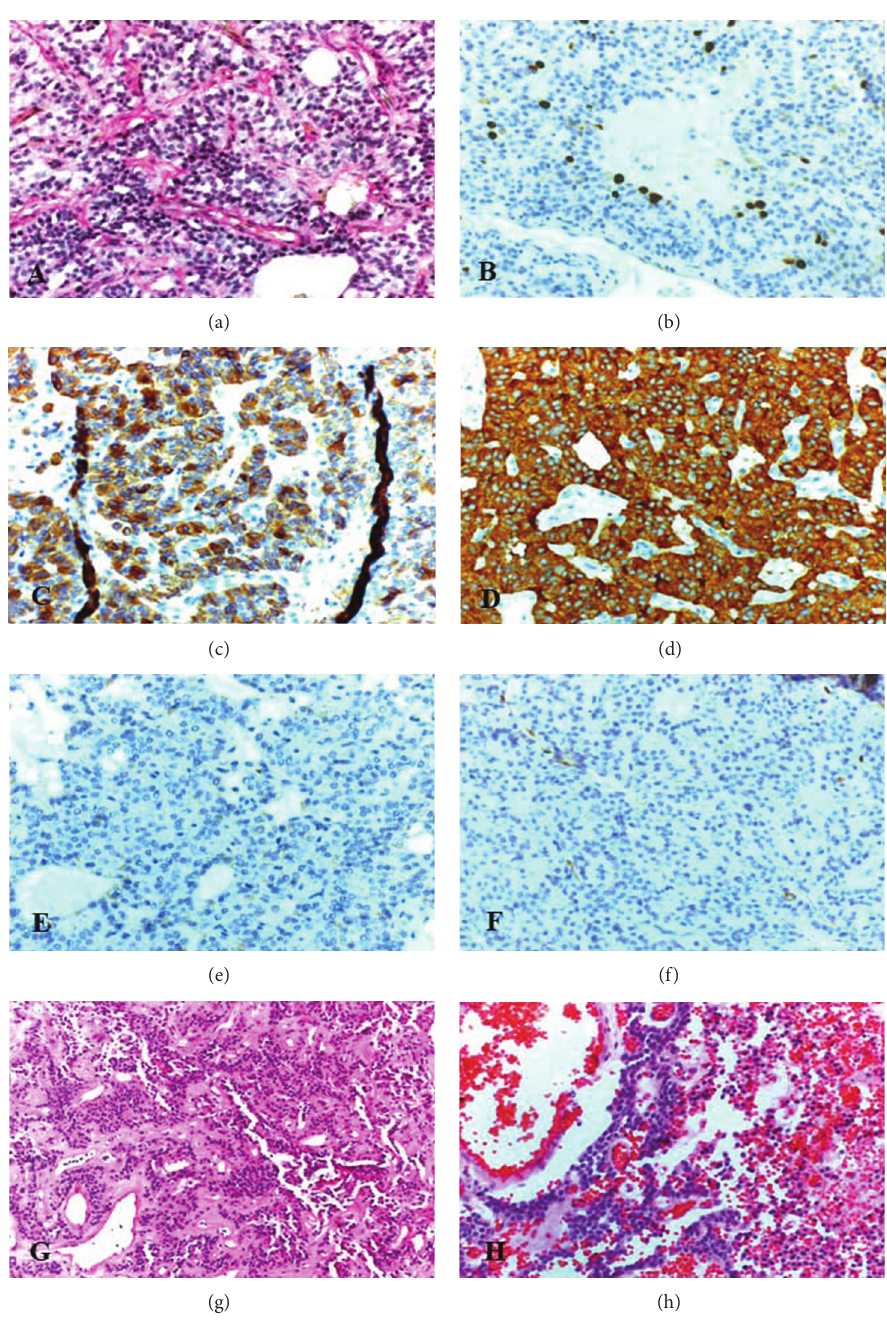
Figure 2: Tumor histomorphology at different time points. (a) In 2007, excised mostly monomorphic highly cellular tumor with regular rounded nuclei and only few mitoses. The blood vessels are regularly arranged resembling a loose meshwork without pathological endothelial proliferation or glycogen storage. (Periodic acid Schiff (PAS), Magnification original × 20.) (b) Immunostaining for the proliferation marker K67 (MIB-1) showing only few proliferating cells (indirect peroxidise technique (LSABII, DAKO, diaminobenzidine (DAB) as a chromogen, brown, Magnification original × 20, counterstaining with Hematoxylin)). (c) Immunostaining for 𝛽 -III-Tubulin (Chemicon), a marker of immature neural cells with strong positivity of all tumor cells. (LSABII, DAKO, (DAB), counterstaining with Hematoxylin Magnification original × 20.) (d) Immunostaining for the neuronal marker synaptophysin (Dako) with strong positive staining of all tumor cells. (LSABII, DAKO, (DAB), counterstaining with Hematoxylin Magnification original × 20.) (e) Immunostaining for chromogranin (Dako), a marker of highly differentiated neuronal cells and ganglion cells with mostly negative staining results. (LSABII, DAKO, (DAB), counterstains with Hematoxylin Magnification original × 20.) (f) Immunostaining for S100 (Dako) showing a mostly negative staining result with single positive cells of glial morphology at irregular intervals (LSABII, DAKO, (DAB), counterstaining with Hematoxylin Magnification original × 20.) (g) Tumor biopsy of 2006 with similar morphology of lower cellularity. Noteworthy are the occasional cell-free areas. (H&E, Magnification original × 10.) (h) Tumor biopsy of 1992 showing similarly organized tumor cells with rounded nuclei and even less mitoses within an extensive hemorrhage. (H&E, Magnification original ×